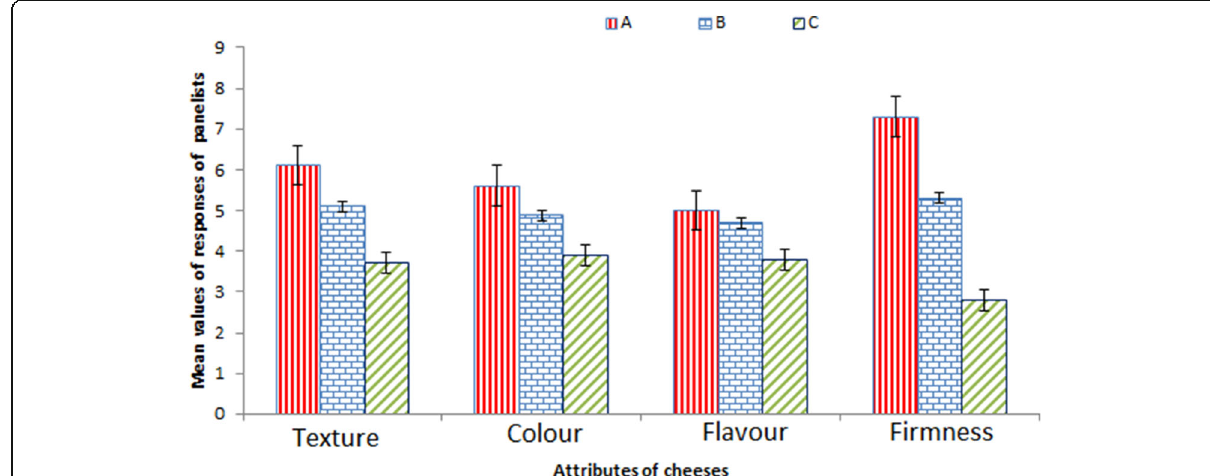
Fig. 8 Sensory evaluation of the